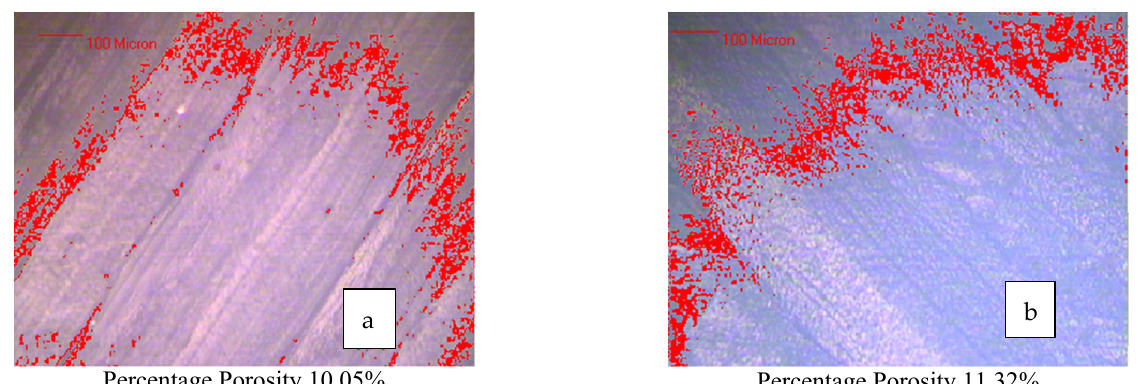
17 of 20 Figure 13. Tool Maker’s microscopic images of flexural tested specimen at ×32 for ( a ) sample 4 (ATA) and ( b ) sample 14 (TAT). 5.2. Porosity Analysis The samples were tested for porosity analysis to consider the factor of voids between the layers concerning the mechanical properties shown by the two different material specimens. For porosity analysis, a 100 ‐ micron scale in metallurgical image analysis setup (MIAS) and ASTM B276 standard was used. After selecting the area for porosity analysis for the samples, it was observed that there was no significant difference between the porosity values of the specimens, as sample 4 and sample 14 held 10% and 11.5% porosity, as shown by Figure 14a,b respectively. This may be due to the fact that each sample of TAT and ATA specimens was 3D printed on 100% infill density and was fixed in a